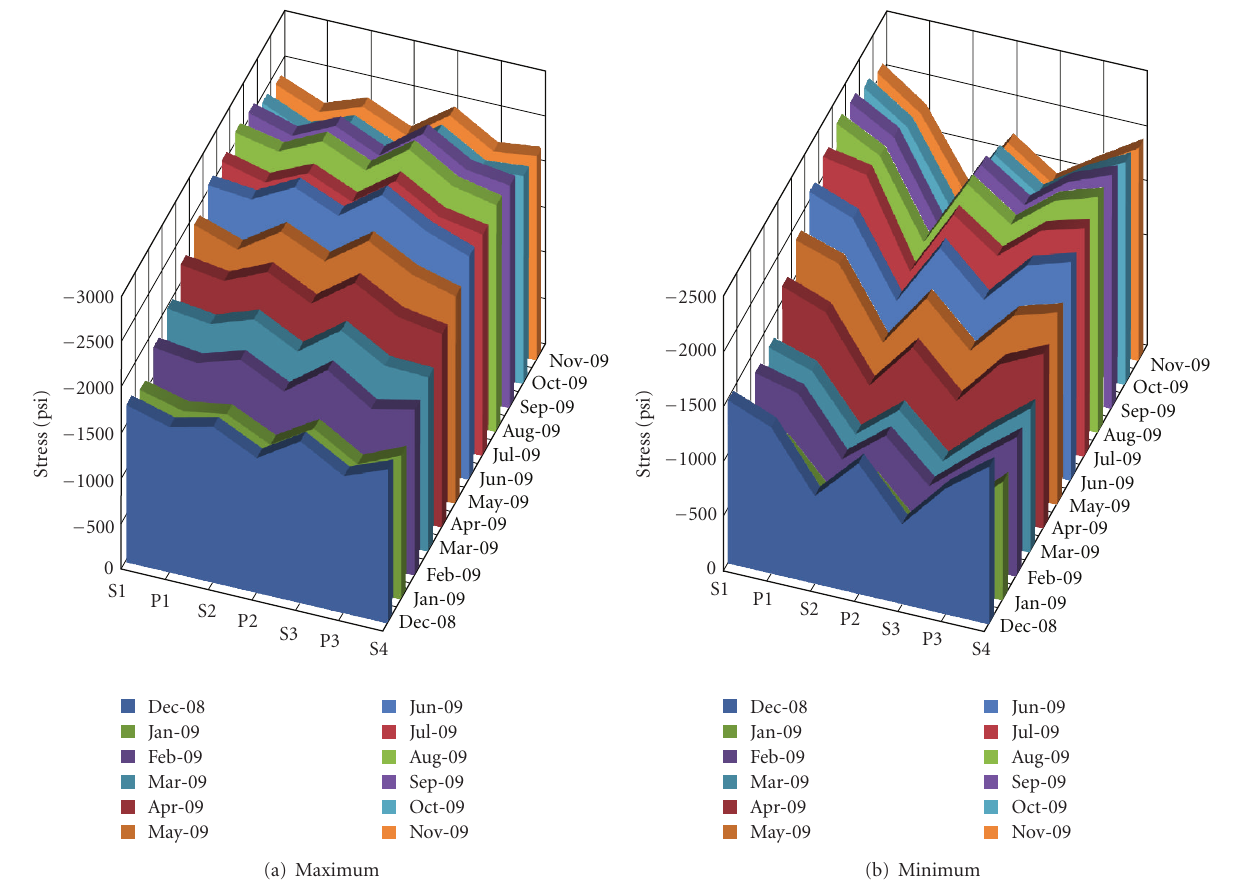
Figure 10: Maximum and minimum longitudinal stresses (psi)—north